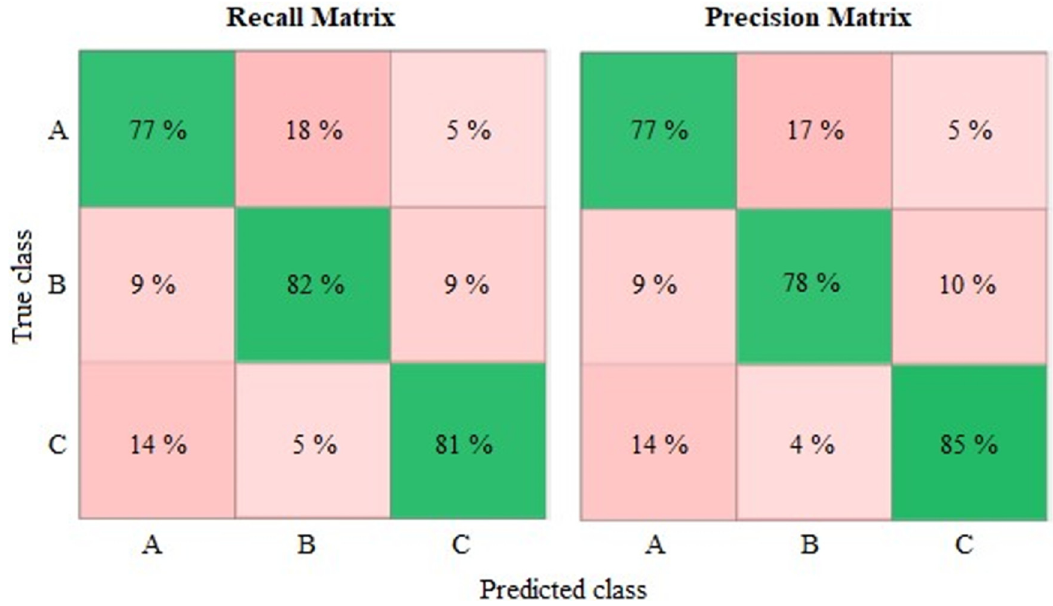
Figure 6. Confusion matrices of Predictive Model 169 for the average primary surface measurement.